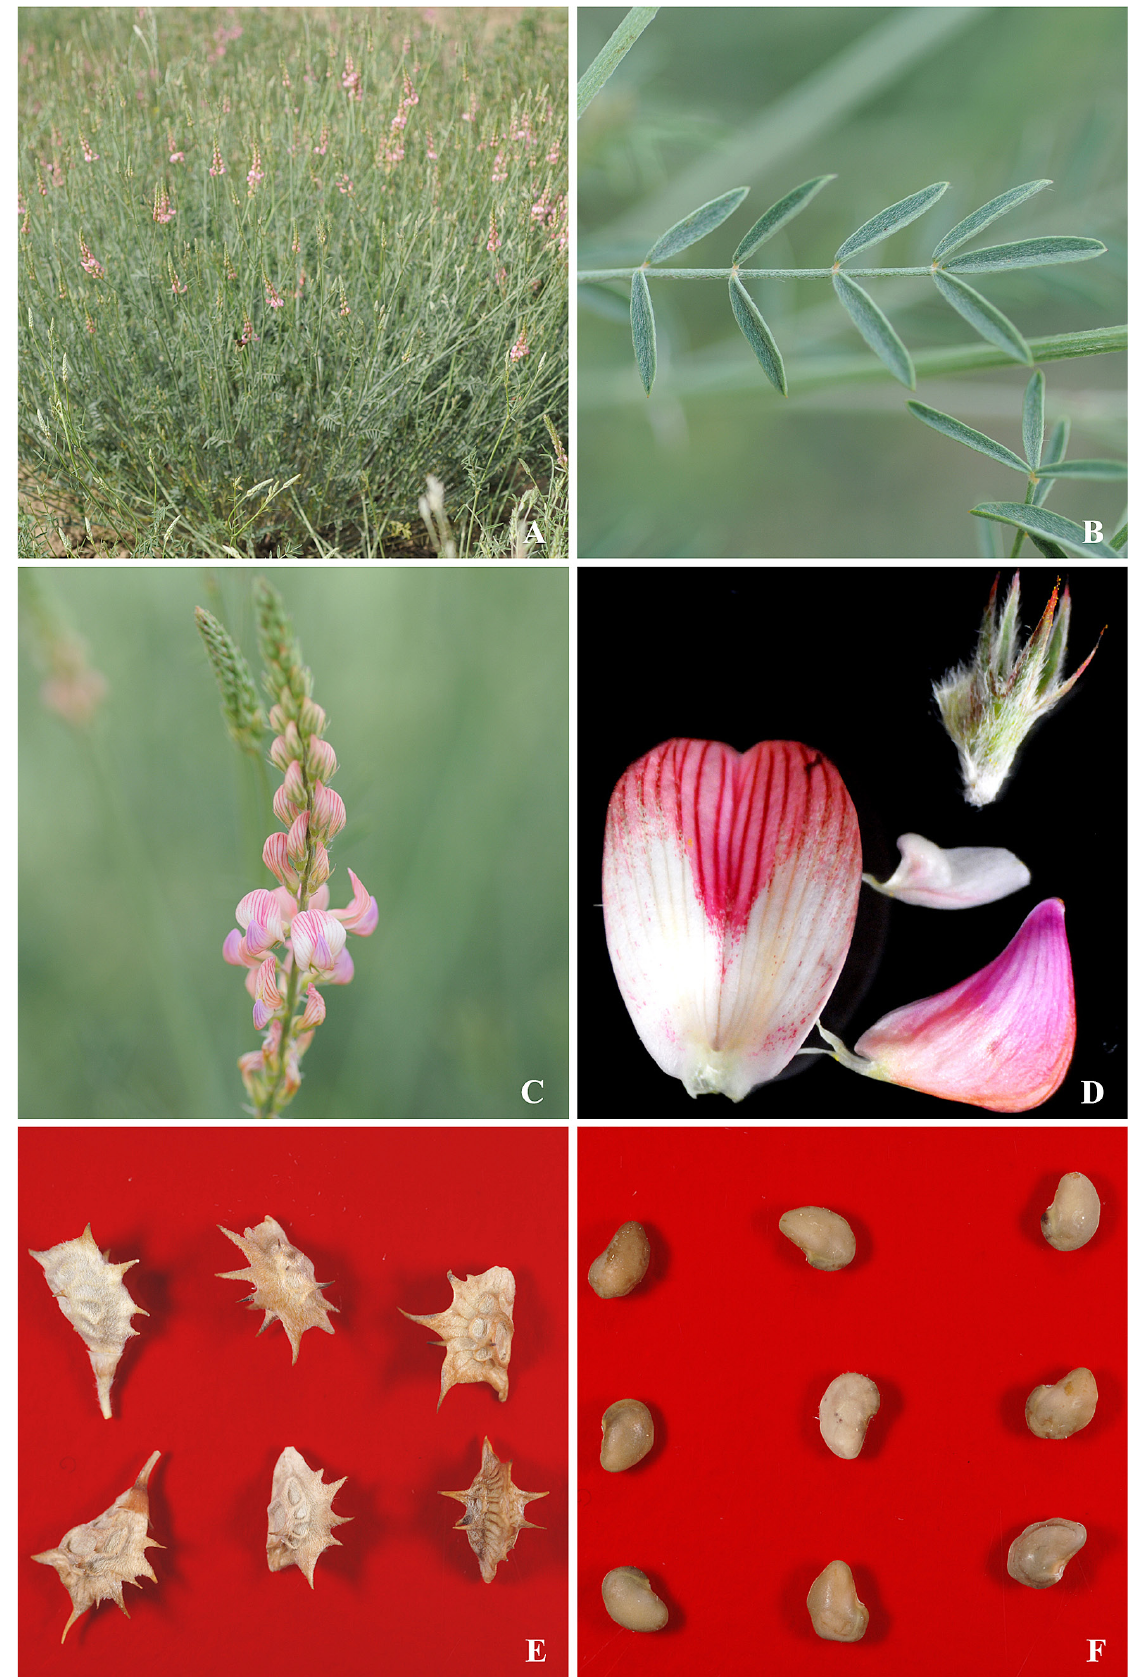
Fig. 1: Morphological characteristics of O. elata . (A) general view with erect stem; (B) leaf; (C) raceme; (D) corolla with calyx; (E) fruits; (F)